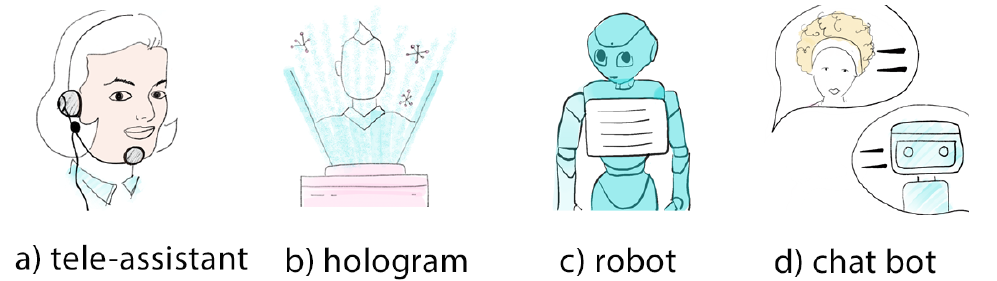
Figure 1. Four Concepts: ( a ) human tele-assistant, ( b ) hologram, ( c ) robot, ( d ) chatbot. 3.